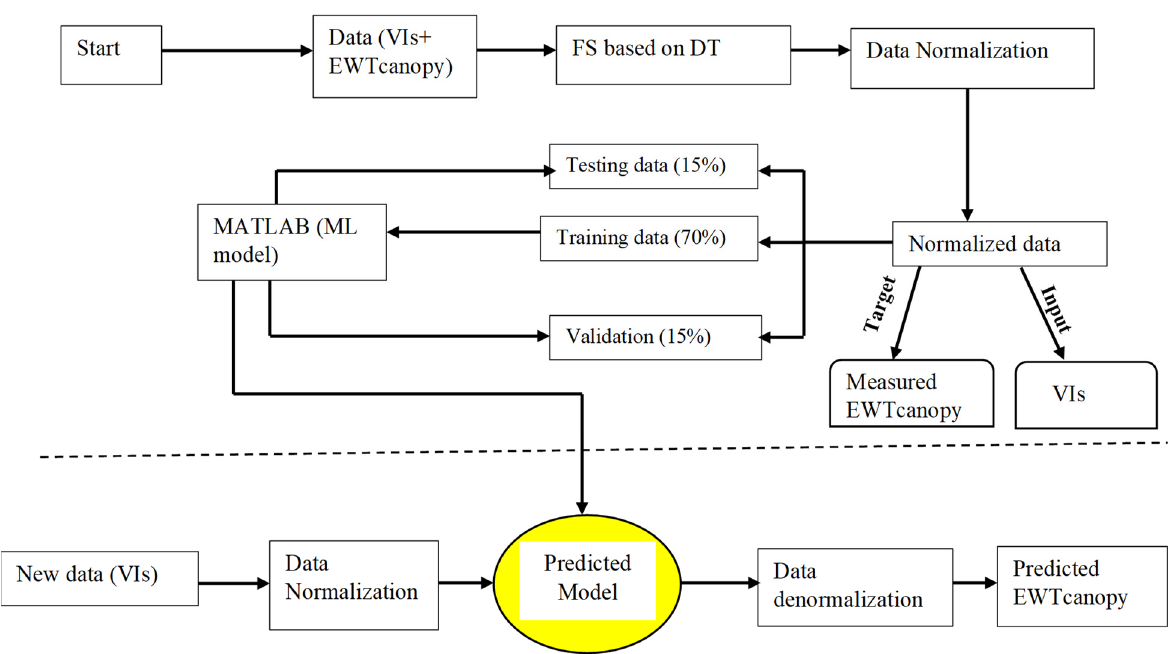
Figure 3. Flowchart of a supervised machine learning model in MATLAB.